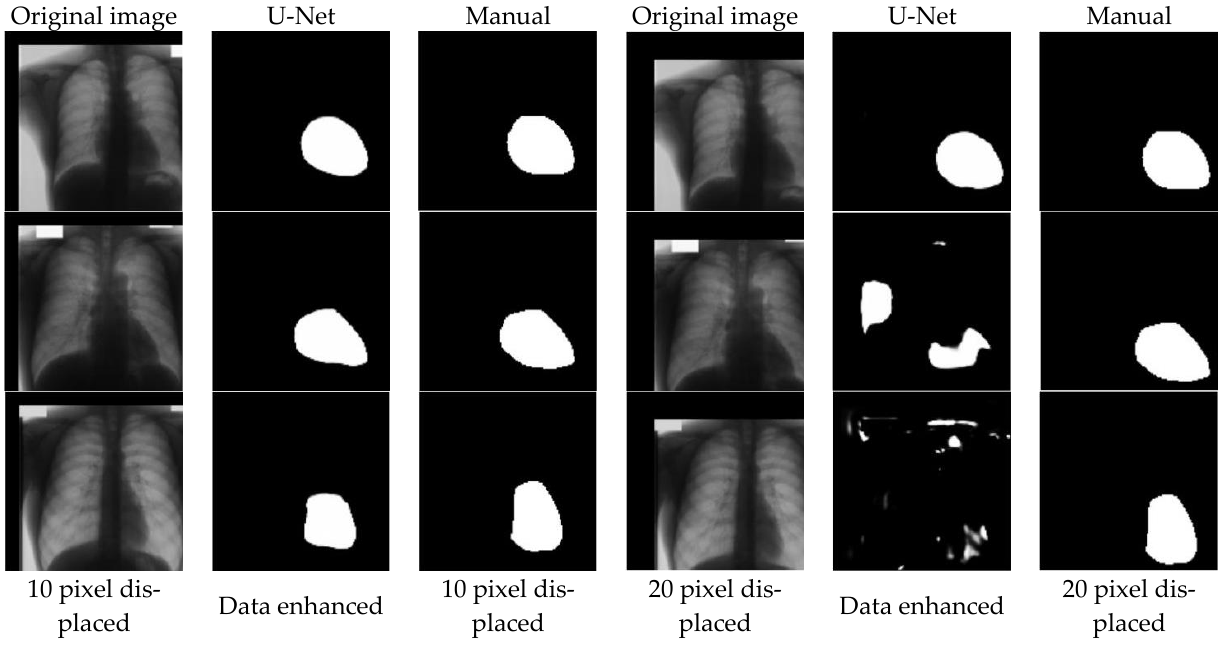
Figure 8. The segmentation results of the displaced image with the original network. (b) Rotation